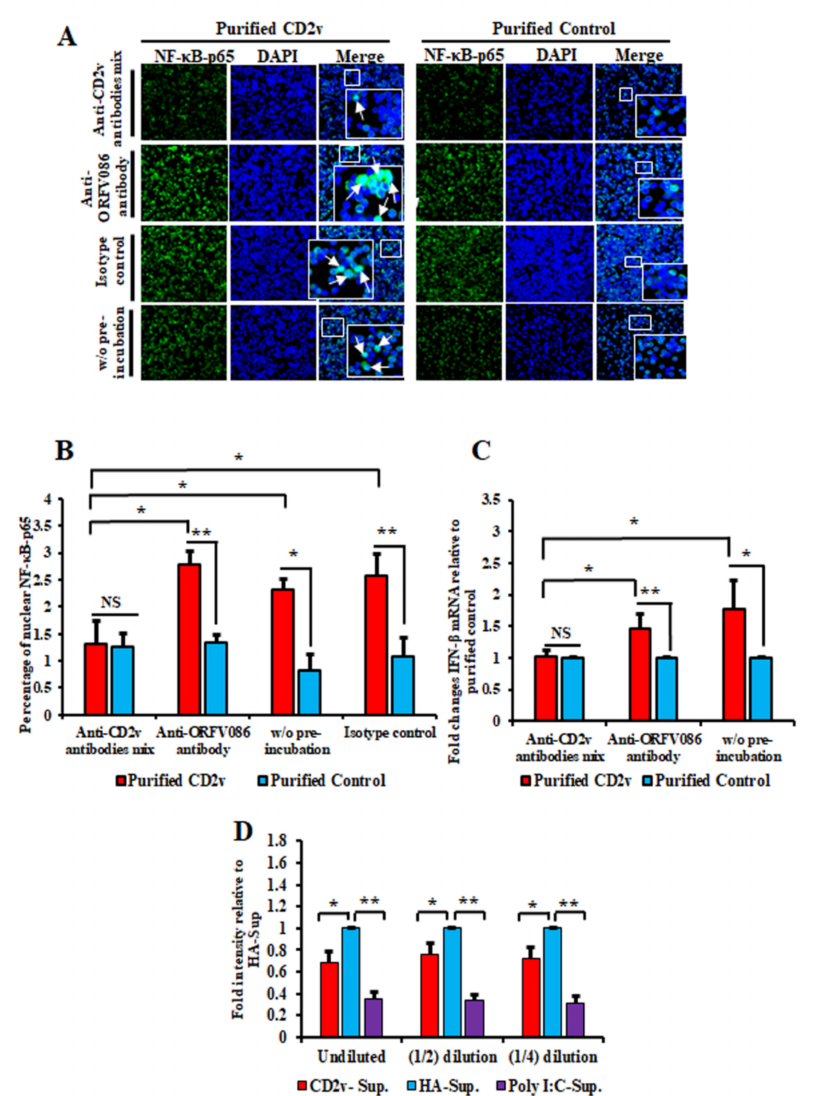
Figure 7. Monoclonal antibodies against ASFV CD2v inhibit CD2v-induced NF- κ B activation and IFN- β transcription in swine PBMC cultures. (A,B) NF- κ B-p65 nuclear translocation in PBMCs. Swine PBMCs were treated for 1.5 h with